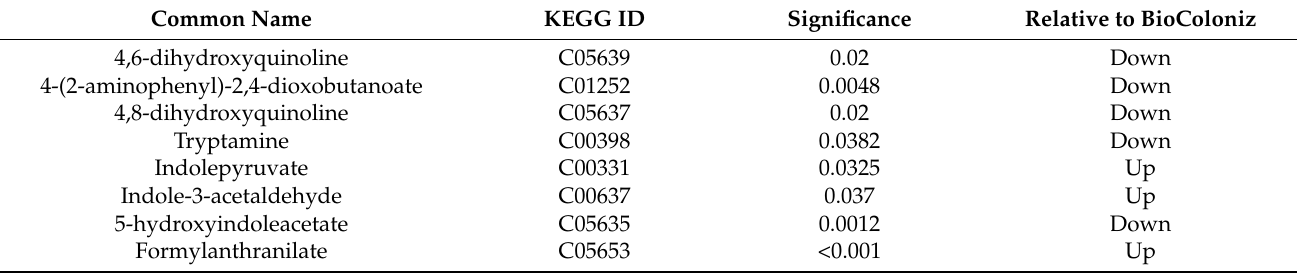
Table 4. Significant features involved in the tryptophan metabolism